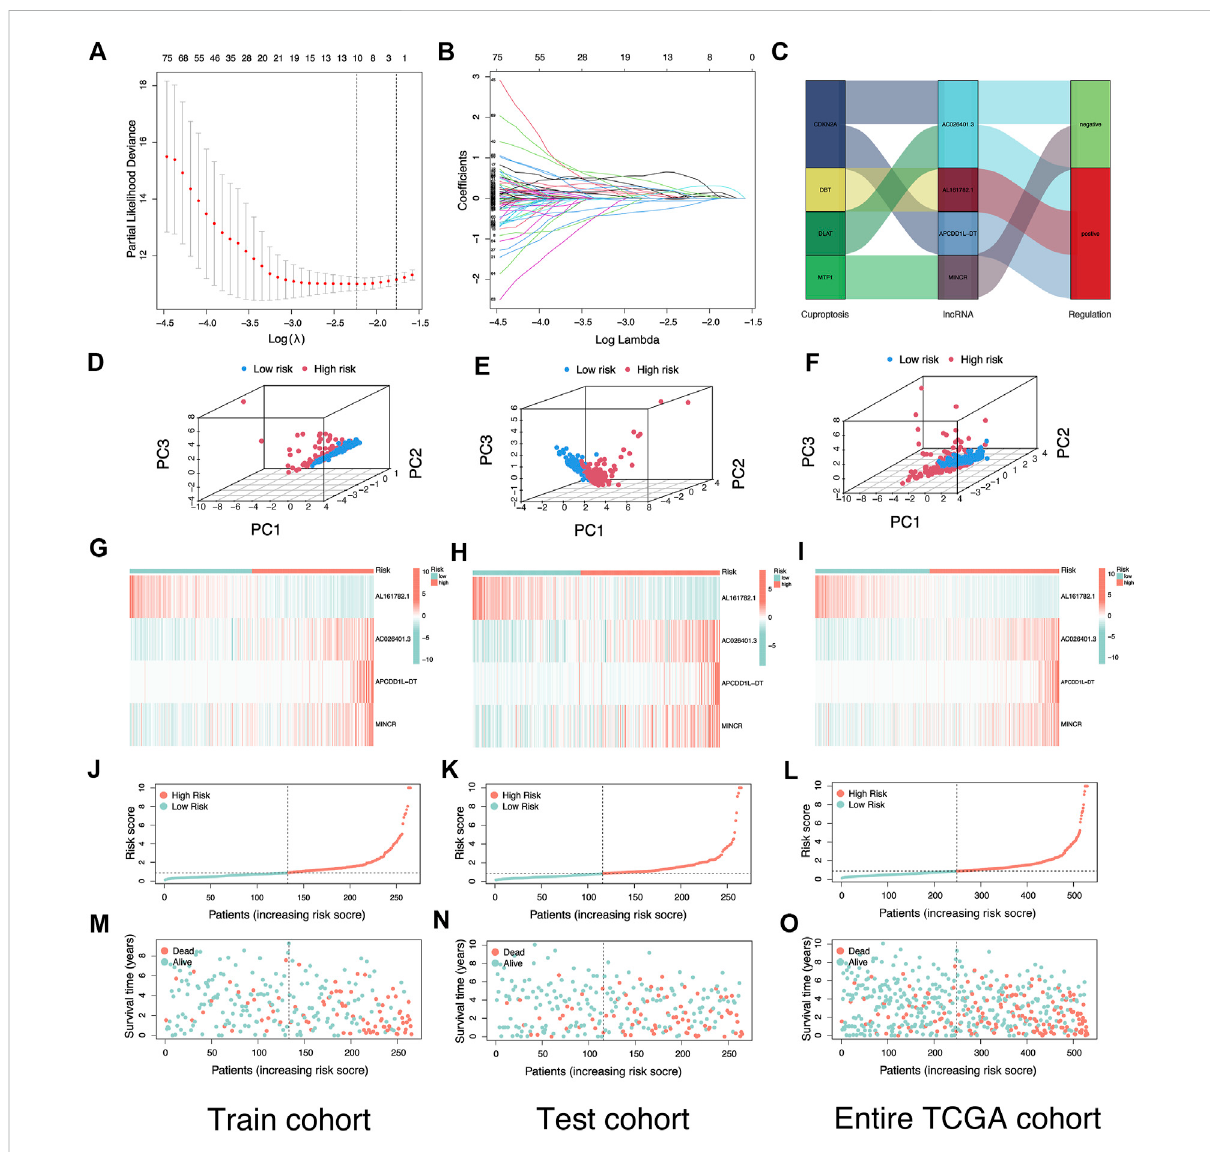
FIGURE 3 Construction and veri fi cation of risk signature based on cuproptosis-related lncRNAs. (A) Cross-validation for variable selection in the LASSO model. (B) Lasso coef fi cient distribution of risk cuproptosis-related lncRNAs. (C) Sankey diagram illustrates the regulatory relationship between Cuproptosis-related genes and lncRNAs. (D – F) The Principal Component Analysis in Train cohort, Test cohort, and Entire TCGA cohort based on differentrisk groups. (G – I) Heatmap of theexpressionof four risk lncRNAs in differentrisk groups inTrain cohort, Test cohort, and Entire TCGA cohort. (J – L) RiskplotdistributionofTraincohort,Testcohort,andEntireTCGAcohort. (M – O) DistributionofsurvivalstatusofKIRCpatientsinTrain cohort, Test cohort, and Entire TCGA